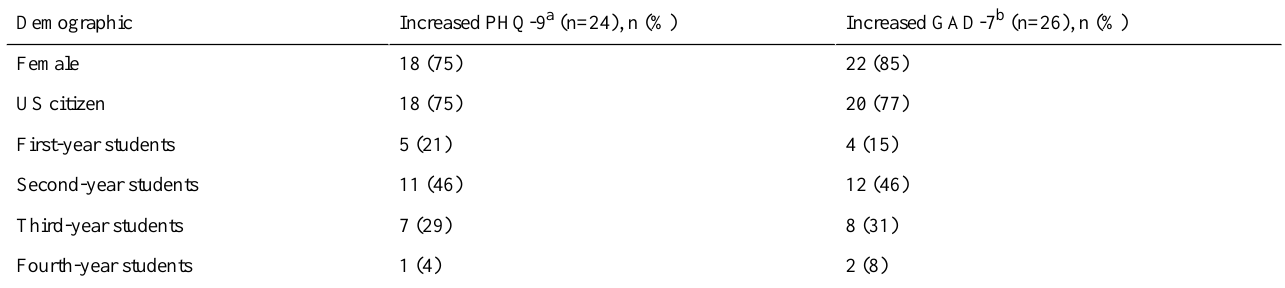
Of the 49 participants, 61% (n=30) of the them were female, 35% (n=17) were male, and 4% (n=2) reported nonbinary genders. First-, second-, third-, and forth-year students occupied 22% (n=11), 41% (n=20), 31% (n=15), and 6% (n=3) of the whole cohort, respectively. A total of 80% (n=39) of the Table 1. Demographics of the study